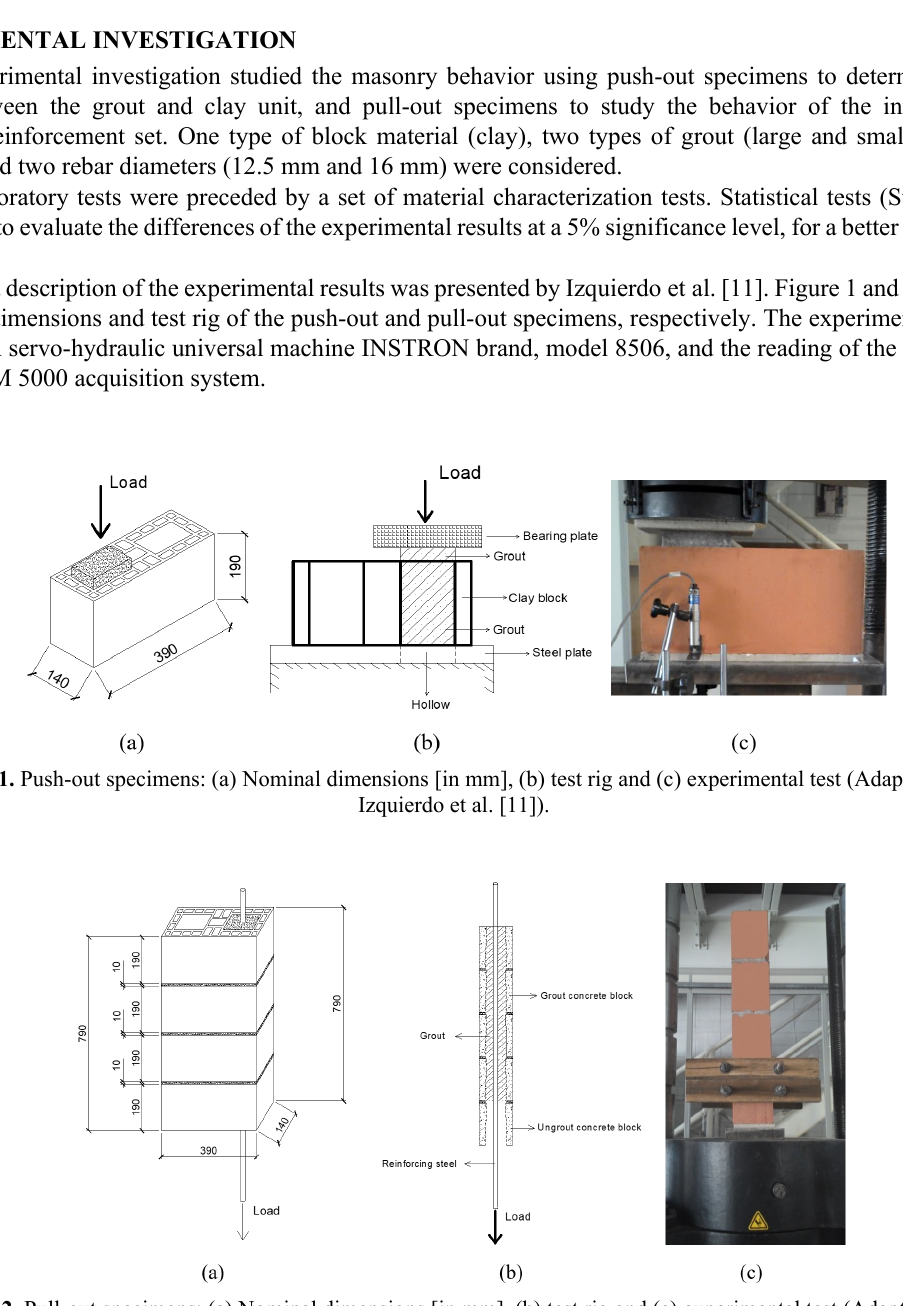
Figure 2. Pull-out specimens: (a) Nominal dimensions [in mm], (b) test rig and (c) experimental test (Adapted from Izquierdo et al.